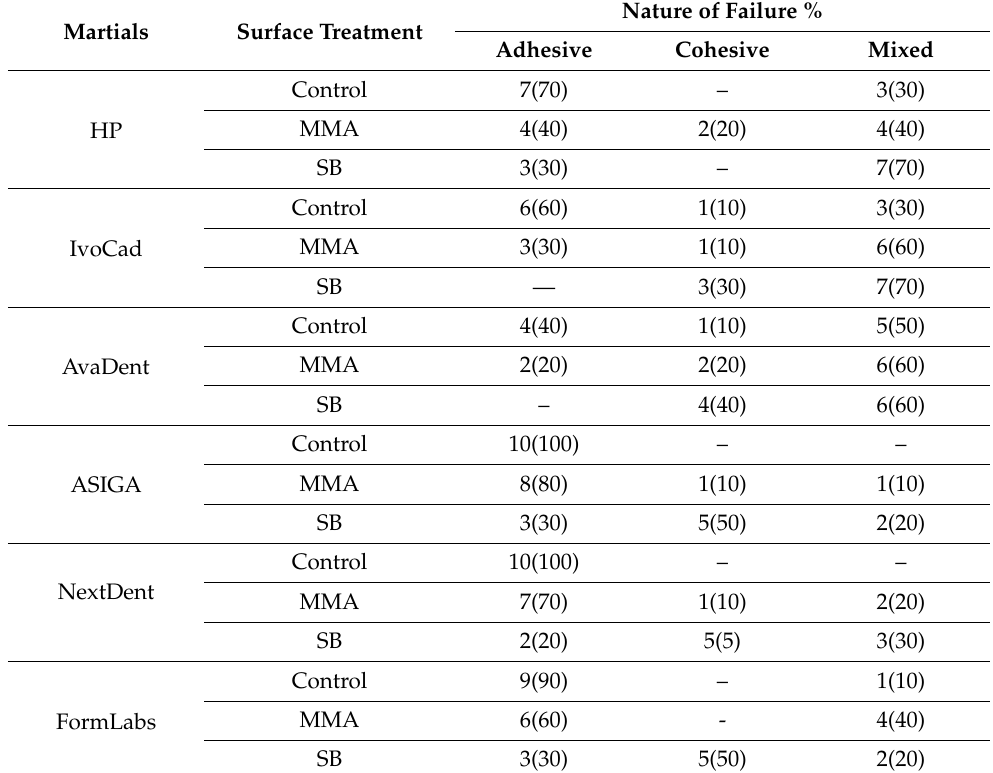
Table 4. Nature of failure in numbers and